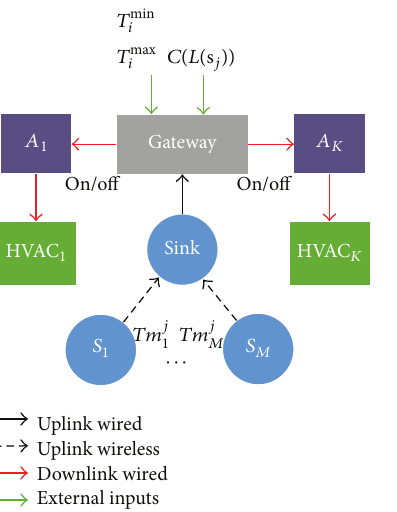
Figure 3: Detailed system model of the HVAC energy scheduler.